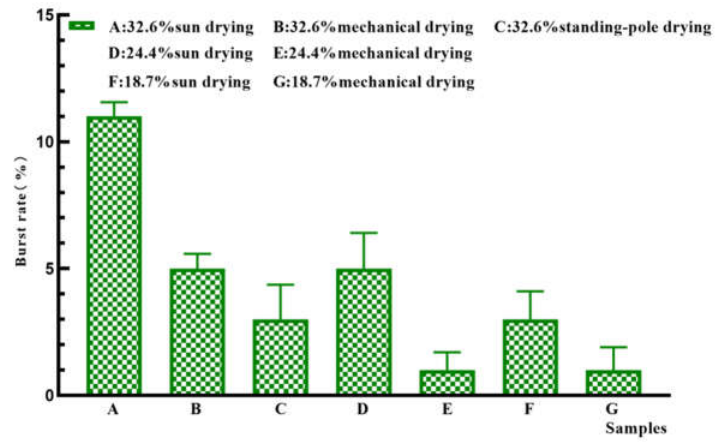
Figure 3. Burst rates of paddy in different drying methods.